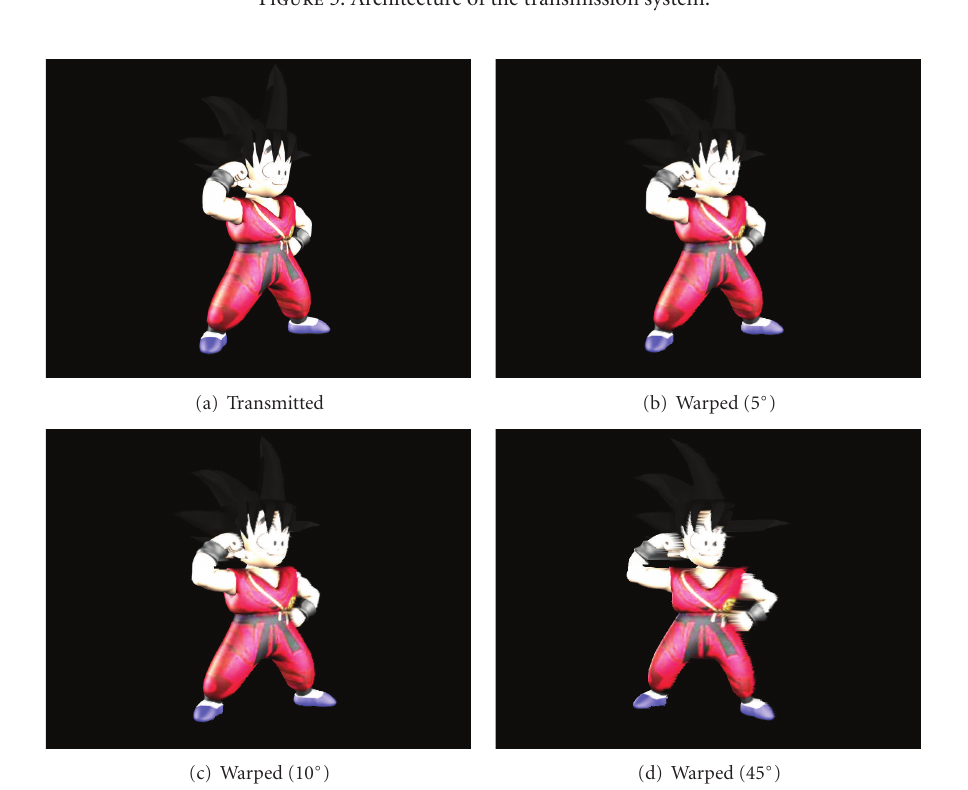
Figure 6: Goku model: transmitted image and rendered views obtained by warping the available one to novel